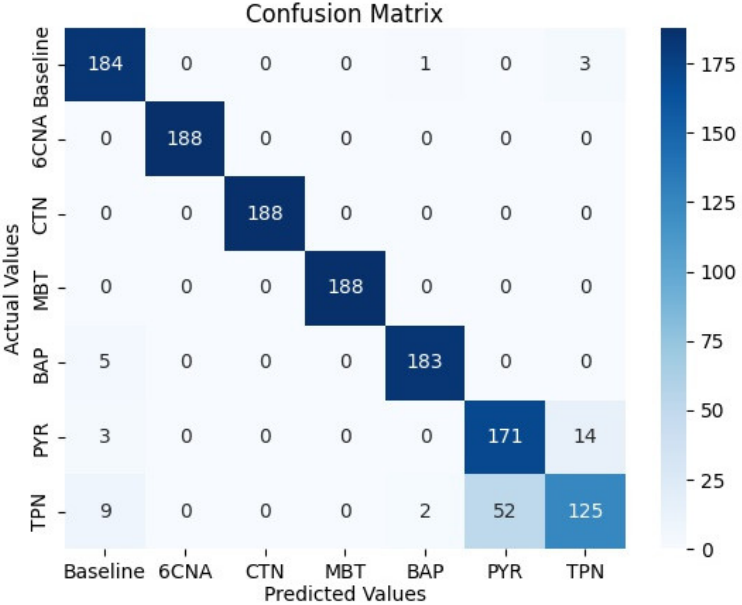
Figure 6. Confusion matrix for anomaly identification using the six contaminants of interests as signals in the test set.